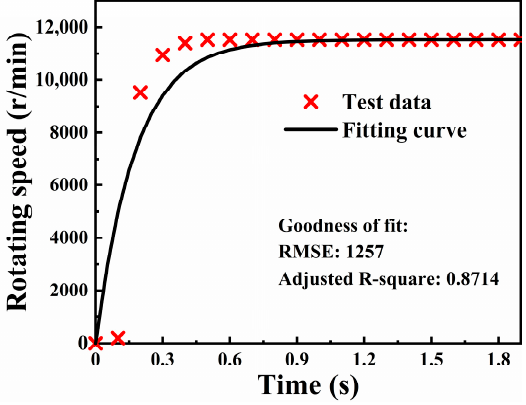
Figure 14. Step response curve of the brushless motor.